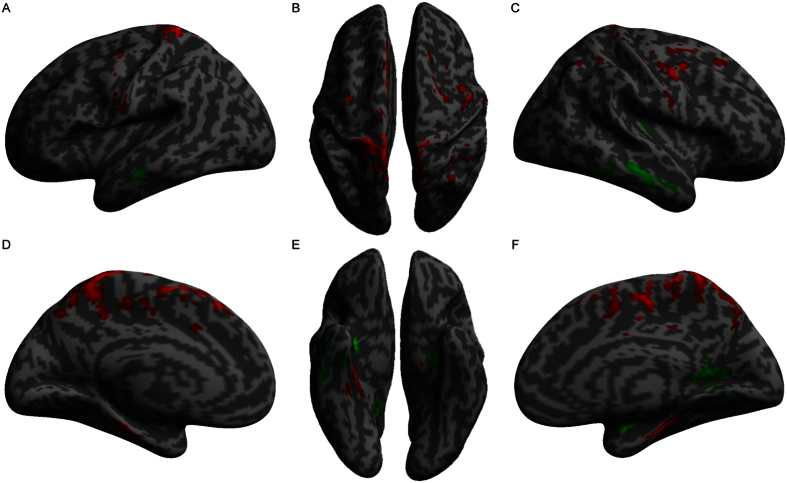
Volumetric differences between patients and normal controls.The red color indicates increased gray matter volume, and the green color indicates decreased gray matter volume in UHL patients compared to normal controls.